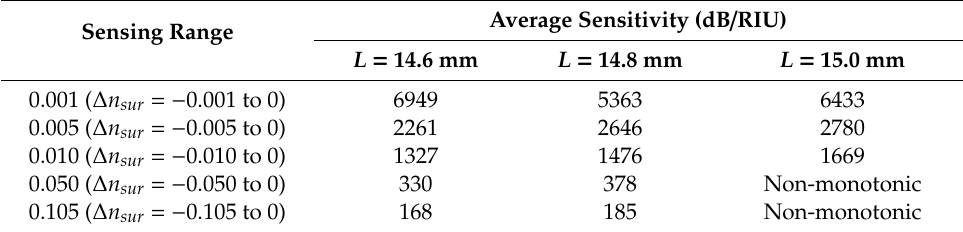
Figure 3. Calculated transmission curves with respect to the surrounding RI for different interaction lengths. Table 1. Sensing performance interrogated through intensity detection at λ = 1550 nm.